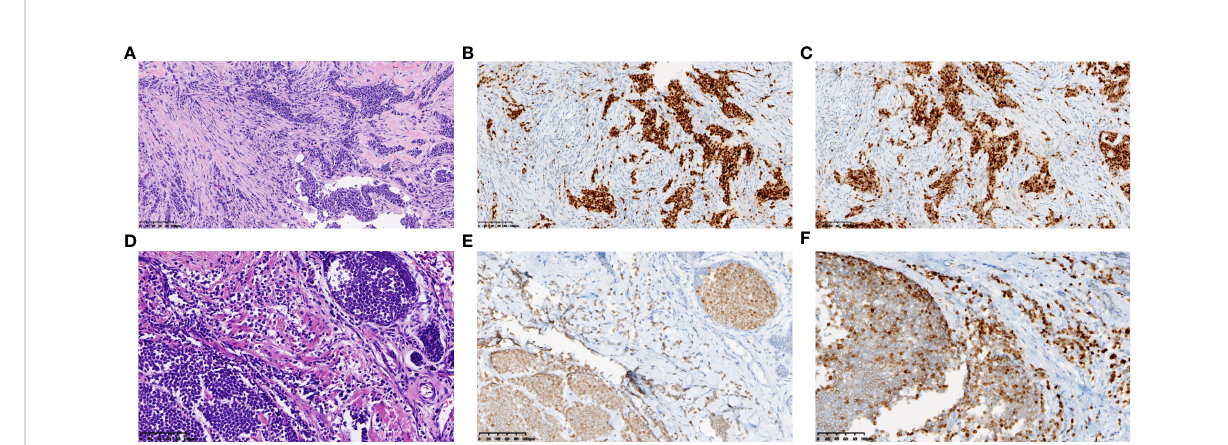
FIGURE 3 Representative histopathological results of the primary lesion in left breast. Needle biopsy revealed classic invasive lobular breast carcinoma (A) . (A, D) show tumor of the resected left breast before (A) and after (D) chemotherapy. (HE staining, ×200, scale bars: 200 µm) Immunohistochemical staining revealed strongly positive expression of ER (B) and PR (C) in the primary lesion, while medially or weakly expressed after chemotherapy (ER E , PR F ). (immunohistochemical staining, ×200, scale bars: 200